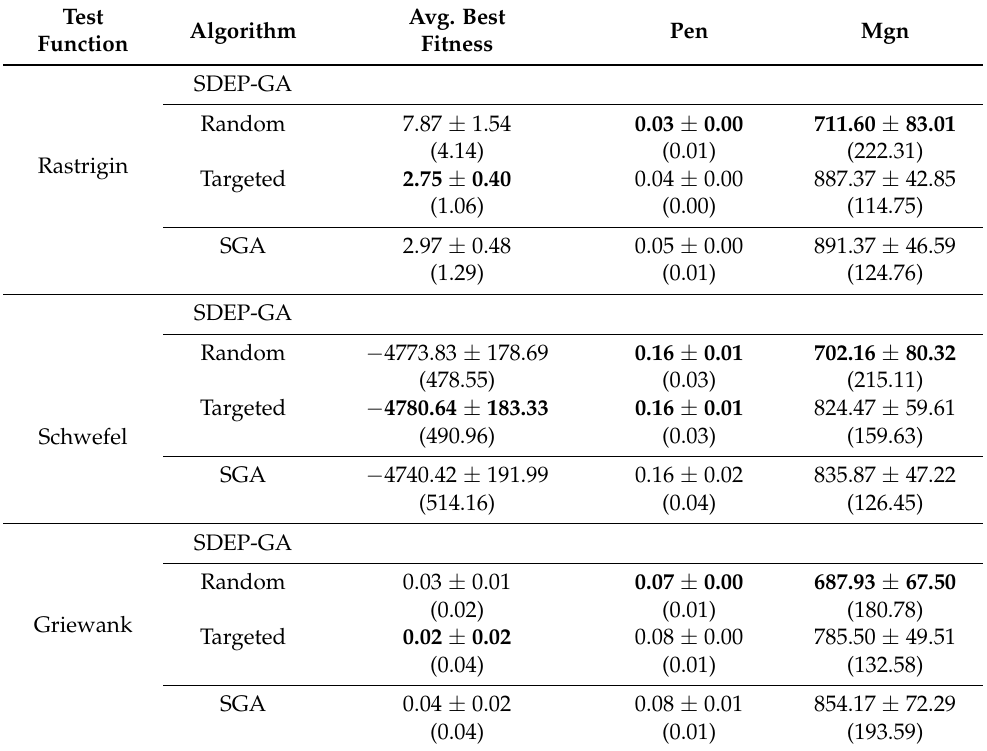
Table 1. Summary of SDEP-GA with random and targeted extinction against SGA; 95% confidence interval is presented after ± sign, and standard deviation is presented inside parenthesis. Minimum results are in bold font. Test Avg.